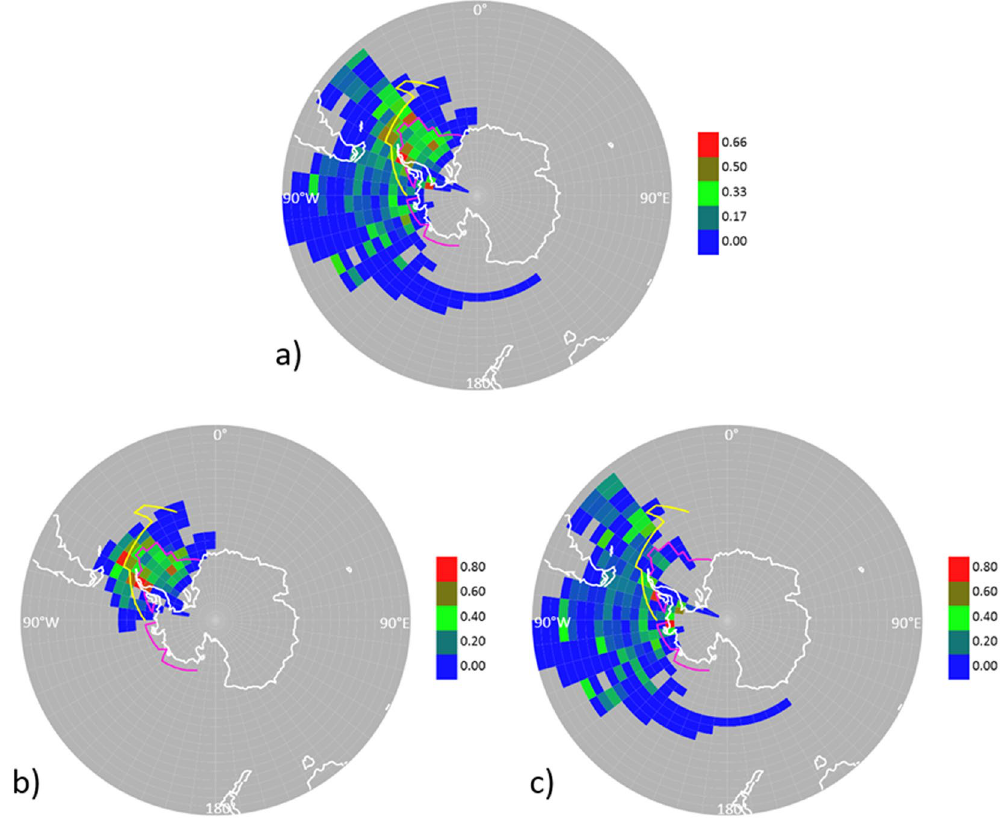
Figure 2. Apportioning of the origin of organic nitrogen in aerosols by Probability Source Contribution Function (PSCF) analysis. Continuous aerosol mass spectrometry data were combined with air-mass back trajectory analysis to quantify the probability of pixels to be the source of high ON concentrations in aerosols (defined as above the 3rd quartile). ( a ) Throughout the entire PEGASO cruise; ( b ) for the first half of the cruise, 8–21 January; ( c ) for the second half of the cruise, 22–31 January. Colour scale indicates PSCF weighting factors. The pink line indicates sea ice extent in January-February 2015. The yellow line indicates the approximate location of the Southern Boundary of the Antarctic Circumpolar Current (SBACC) within the 19–90° W sector, which defines the extent of major Weddell Sea ice influence on the contiguous ocean. This plot was created using the R software (R Development Core Team, R i386 3.3.2;